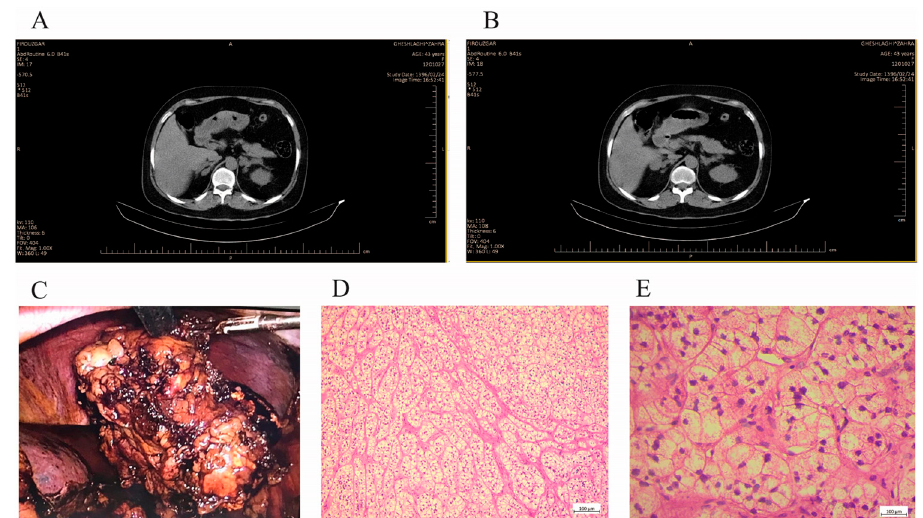
Figure 3. Clinical data of the proband (III-6). ( A , B ) Abdominal CT scan images showed bilateral irregular adrenal masses, adrenal glands are replaced by multiple nodules. ( C ) Macroscopic cross- sectional view of the resected formaldehyde fixed right adrenal gland with yellowish nodules of various sizes. ( D , E ) Histological view of hematoxylin-eosin (HE) staining of resected tissues showed diffuse hyperplasia of zona